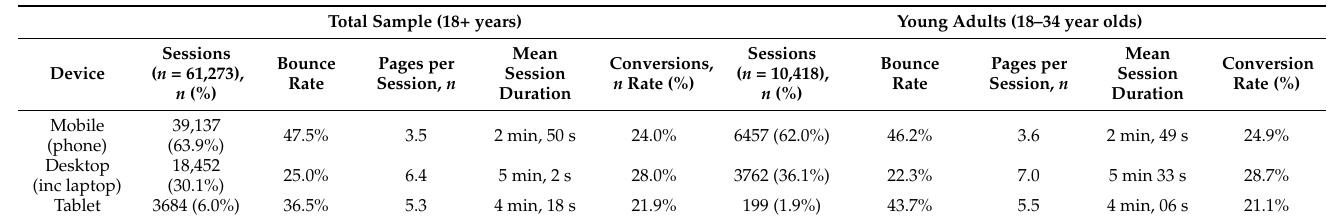
Table 8. Proportion of total sessions by